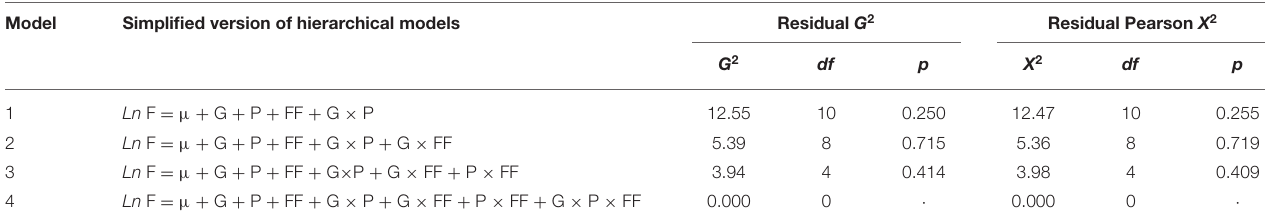
TABLE 11 | Logit model analysis of proportional focus of feedback by students’ gender and performance.